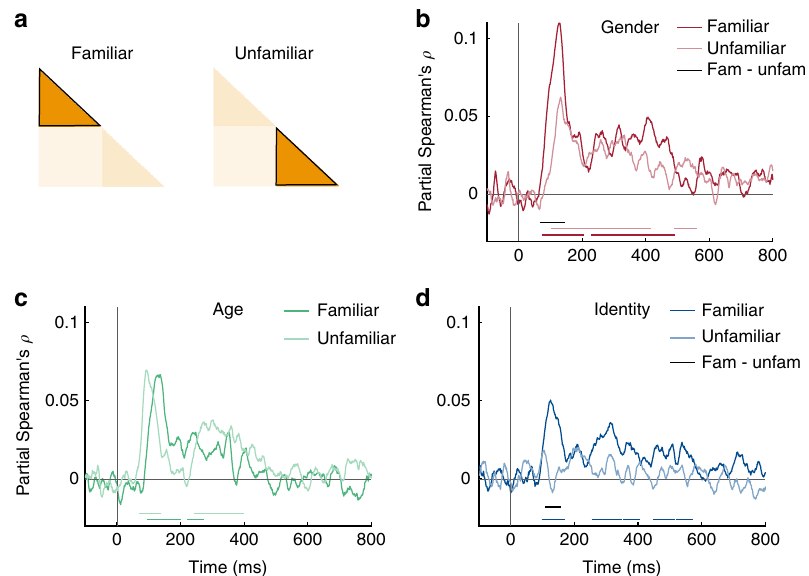
Fig. 3 Effect of familiarity on face representations. a We conducted separate RSA analyses for familiar and unfamiliar faces ( n = 16). Note that this reduces the amount of data fourfold. b – d Time course of partial Spearman correlations between MEG RDMs and gender ( b ), age ( c ) and identity ( d ) separated for familiar and unfamiliar faces, partialling out other models and low-level features (see Methods). Colored lines below plots indicate signi fi cant times, and black lines indicate signi fi cant difference between conditions both using cluster-based sign permutation test (cluster-de fi ning threshold p < 0.05, and corrected signi fi cance level p < 0.05). Source data are provided as a Source Data fi